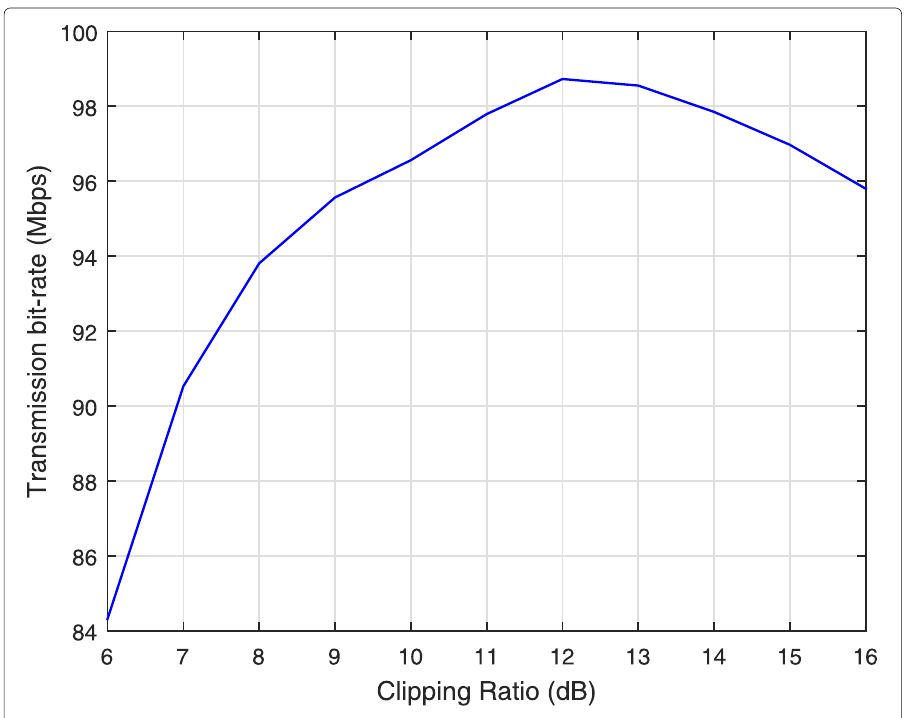
Fig. 12 Relationship between transmission bit rate and clipping